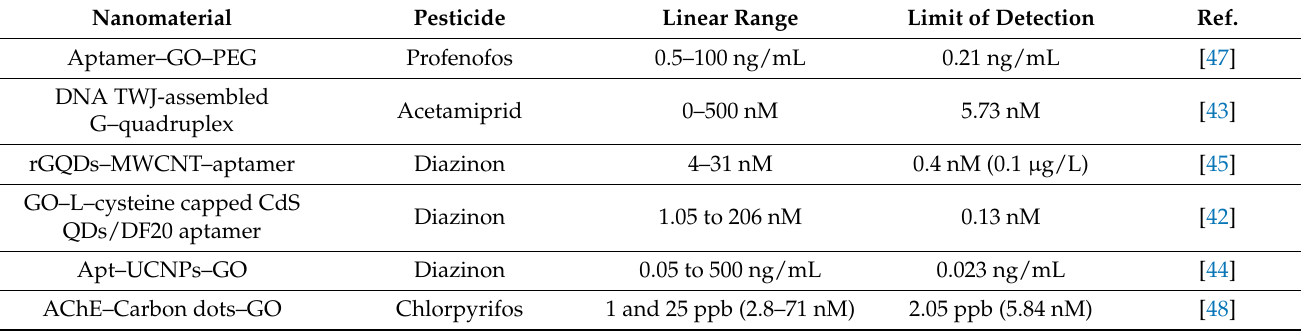
Table 2. Fluorescence sensing of pesticides using GO/rGO